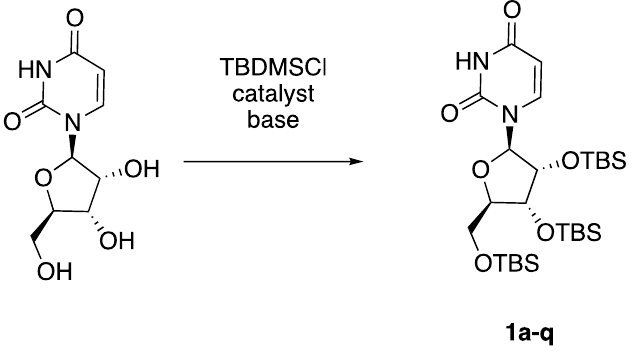
Table 1. O -silylation of uridine with TBDMSCl using different catalysts, solvent bases and reaction